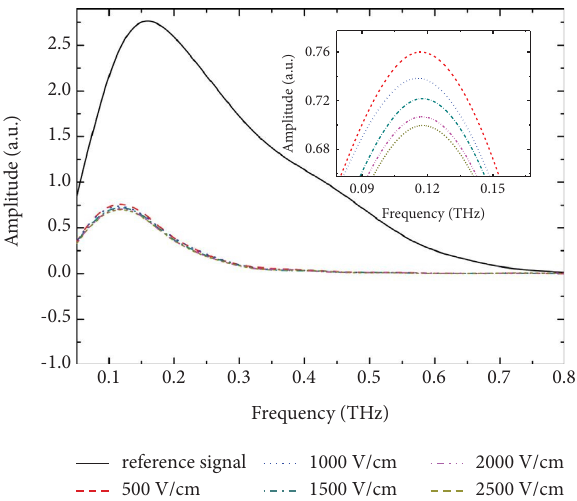
Figure 8: THz frequency-domain spectra of MWCNT aqueous dispersion under diferent EF intensities.